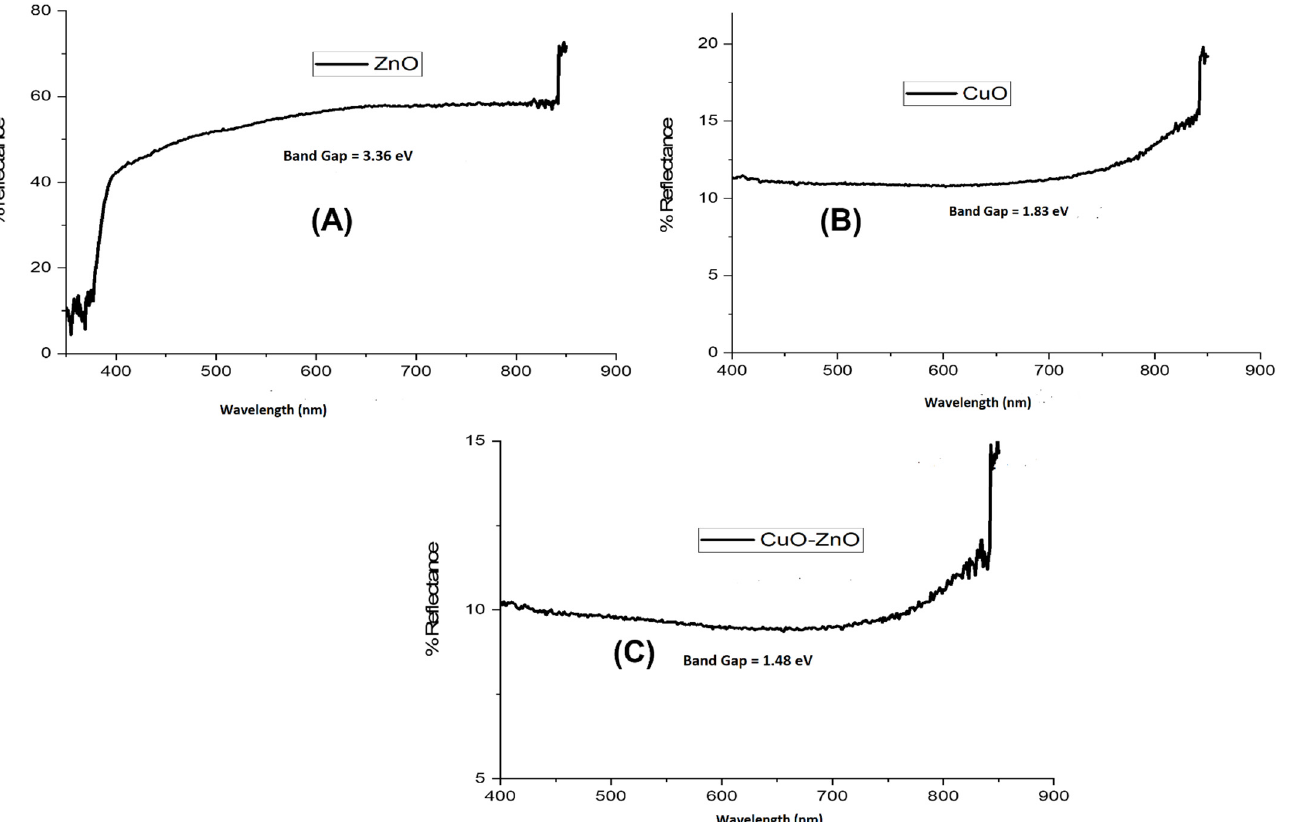
Figure 4. DRS spectra of ( A ) ZnO, ( B ) CuO Nps and ( C ) ZnO/CuO nanocomposite. The X-ray diffractograms of the CuO and ZnO nanoparticles and CuO/ZnO nanocomposite are given in Figure 5A–C, respectively. The X-ray diffractogram of the ZnO